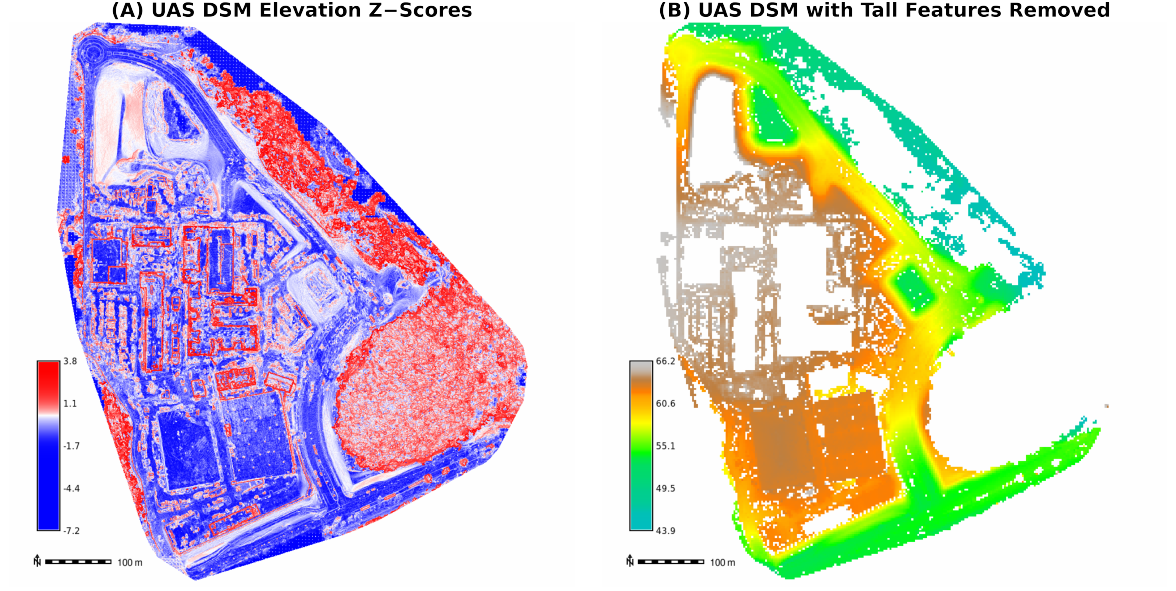
Figure A1. A bare earth DEM of the UAS data was created by hierarchically filtering tall features from the UAS DEM based on their z-score ( A ). The resulting DSM ( B ) contained holes where vegetation, buildings, and vehicles were removed that were filled through using regularized spline interpolation.